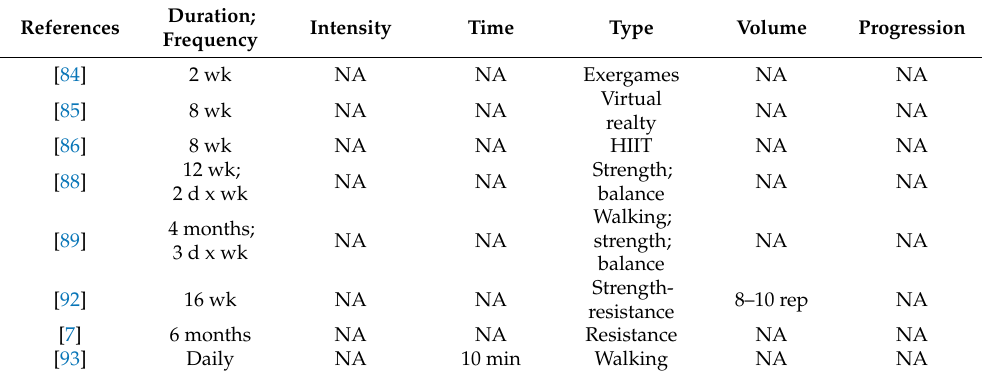
Table 7. The principles of exercise prescription of chronic diseases during COVID-19.